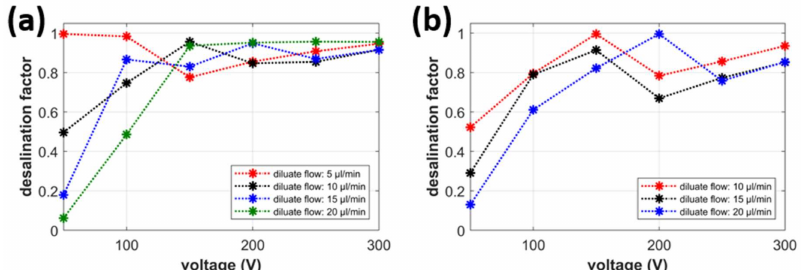
Figure 3. Desalination factor; ( a ) voltage dependence ( V C = 2 µ L/min), ( b ) voltage dependence ( V C = 5 µ